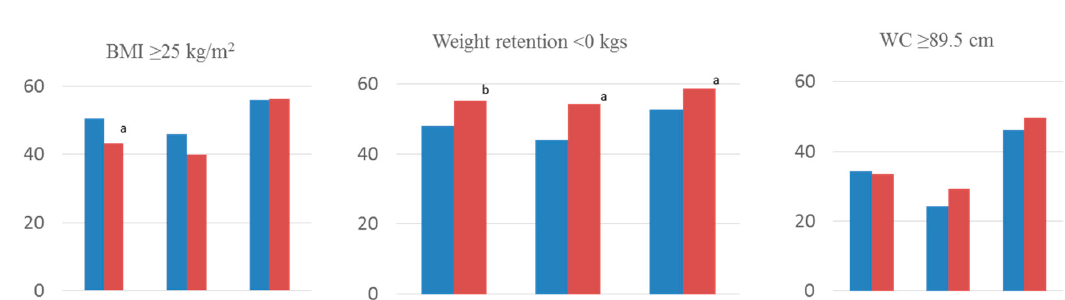
Figure 1. Rates of components of MetS concerning ( a ) lipid abnormalities, ( b ) glucose regulation, ( c ) blood pressure, and ( d ) anthropometric parameters. Standard-care group early intervention group. BMI, body mass index; WC, waist circumference; SBP, systolic blood pressure; DBP, diastolic blood pressure; C-HDL, HDL cholesterol; TG, triglycerides; FPG, fasting plasma glucose; GDM, gestational diabetes mellitus; NGT, normal glucose tolerance. a: p < 0.05; b: p < 0.01; c: p < 0.001.